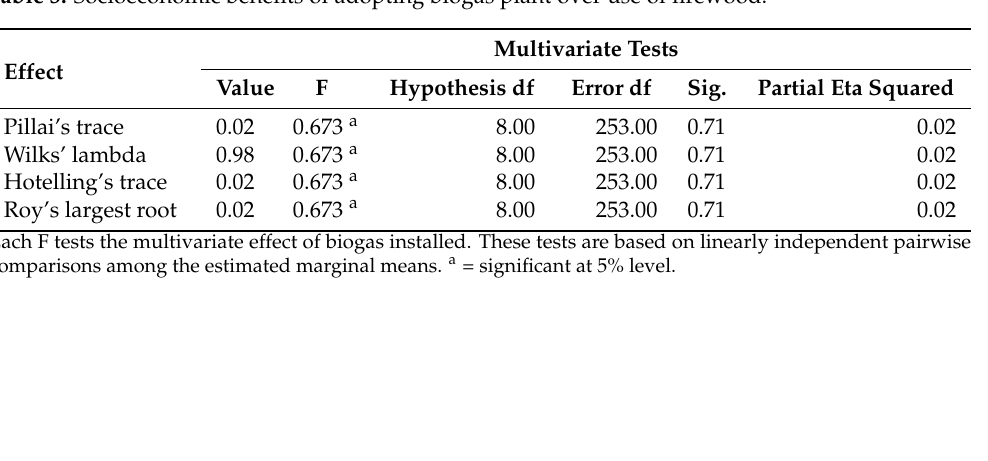
Table 3. Socioeconomic benefits of adopting biogas plant over use of